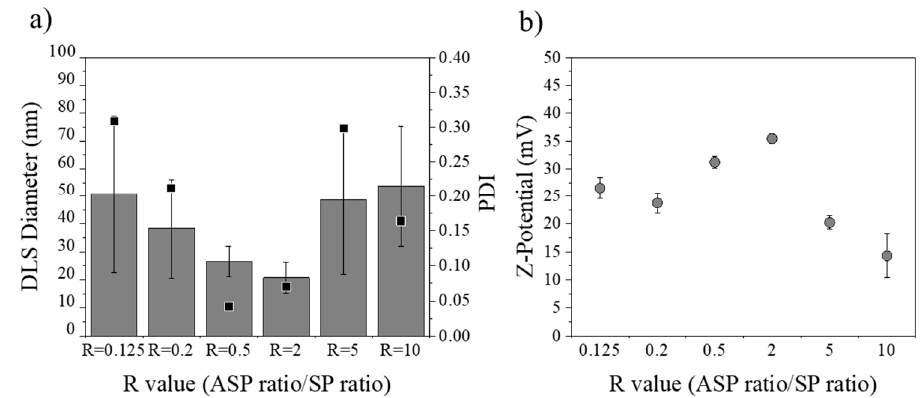
Figure 9. ( a ) DLS diameter and polydispersity index (PDI) of Eudragit ® RS100 10% (w/v) EtOH:acetone of different R values at 50 mL/min of total flow (n = 3), ( b ) Z-potential of Eudragit ® RS100 10% (w/v) EtOH:acetone of different R values at 50 mL/min of total flow.